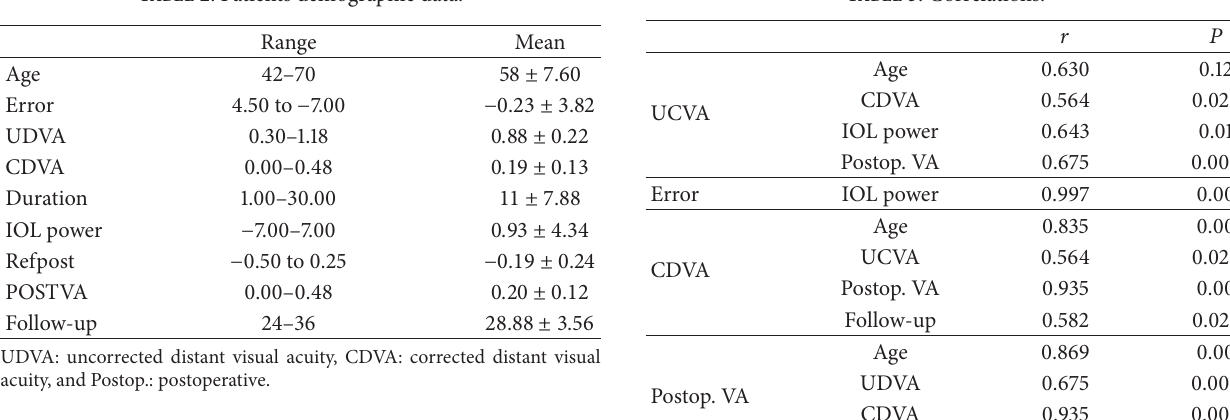
Table 3: Correlations.